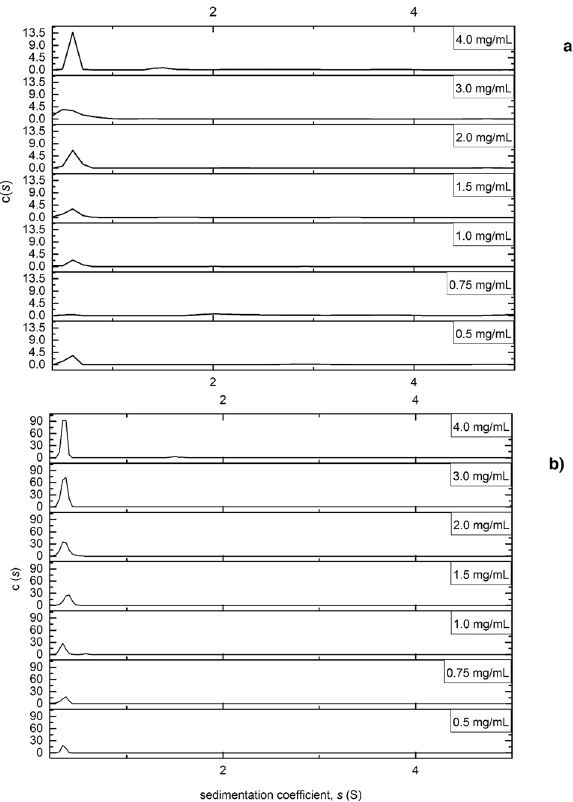
Figure 4. Sedimentation coefficient distributions c( s ) vs sedimentation coefficient (S) for ( a ) TPA6 and ( b ) TPA7 in isopropanol. Rotor speed = 49,000